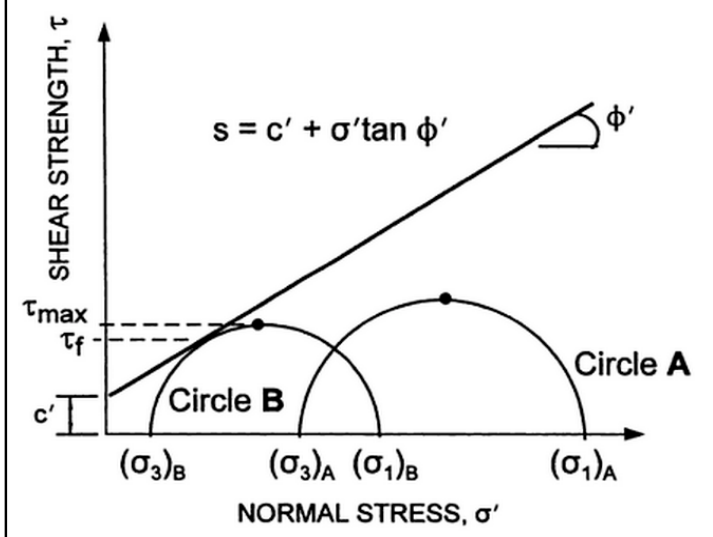
Figure 5. Mohr – Coulomb Failure Envelope for Shear Strength of Soils [34]. Figure 5. Mohr–Coulomb Failure Envelope for Shear Strength of Soils